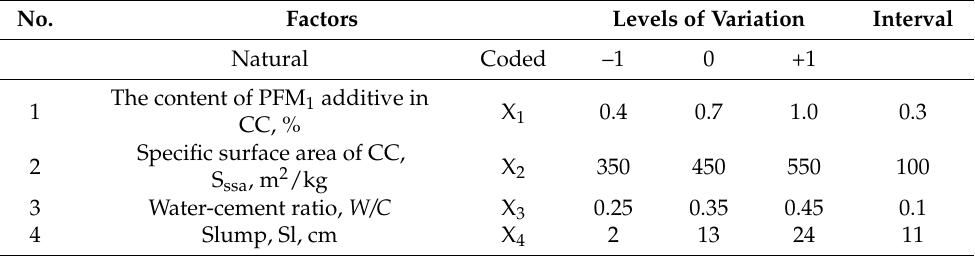
Table 4. Conditions for planning experiments when obtaining models of the concrete mixture water consumption and the concrete at the CC strength.